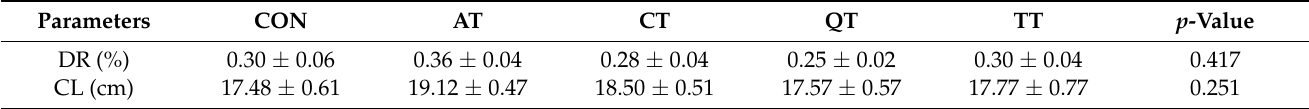
Table 4. Effects of adding different tannins to the diet on diarrhea rate and cecum length of broilers (mean +